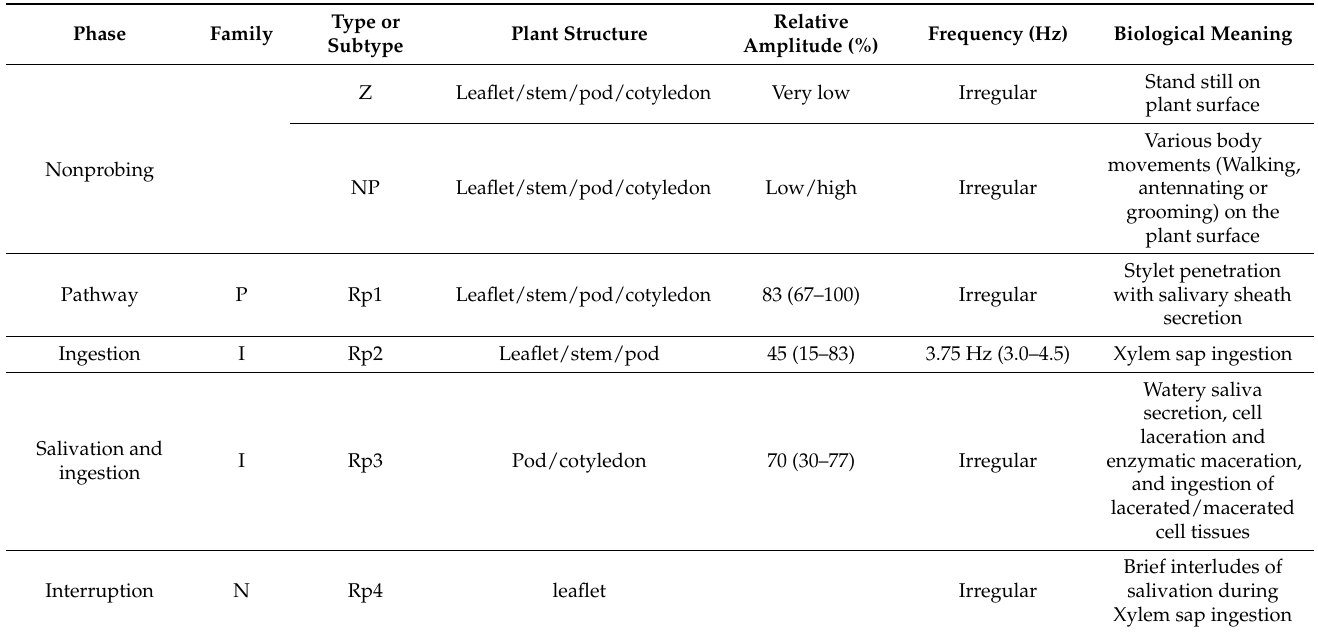
Table 1. Description of waveforms recorded using EPG during the feeding of Riptortus pedestris instars and adults on soybean plants, and their biological